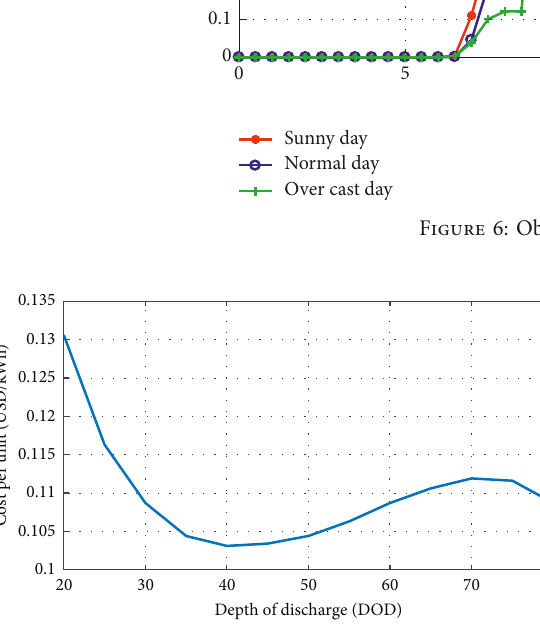
Figure 7: Battery unit cost variation with DoD. Table 3: Simulation time comparison. Load